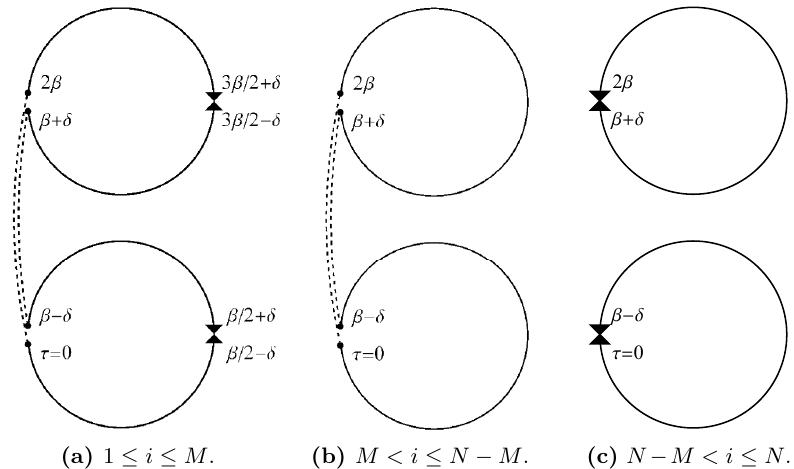
Figure 17. Imaginary time contour τ ∈ (0 , 2 β ) for the Euclidean path integral computing the numerator of equation (C.5) when M < N/ 2 . The twist operator inserted in the left system is indicated by the dashed line. The insertion of a measurement operator in the left and right sides is indicated by the triangles. When the projective measurement operator is inserted in the left side, the effect of the twist operator is trivial and we therefore omit the dashed line. (a) Boundary conditions (C.8) for Majorana fermions ψ i , 1 ≤ i ≤ M . (b) Boundary conditions (C.9) for Majorana fermions ψ i , M < i ≤ N − M . (c) Boundary conditions (C.10) for Majorana fermions ψ i , N − M < i ≤ N